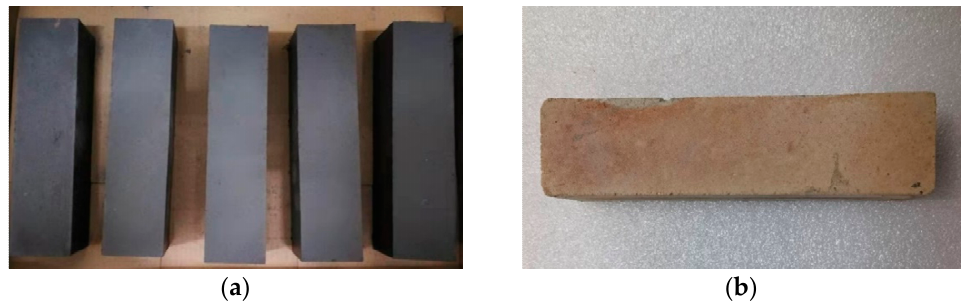
Figure 4. Bricks before and after sintering: ( a ) Unsintered bricks, ( b ) Sintered brick.